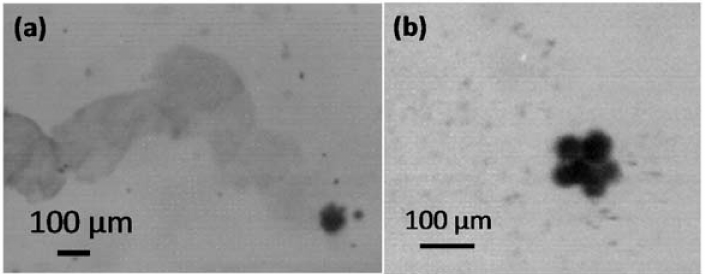
Figure 8. ( a ) Images of a trail of sodium chloride crystals being left behind in the wake of a moving cluster of cavitating bubbles; ( b ) Enlarged image showing sodium chloride crystals being emitted from the cavitation bubble cluster during sonocrystallisation. Cavitation was generated by a 33.1 kHz plate transducer. Adapted with permission from [17]. Copyright (2018) American Chemical